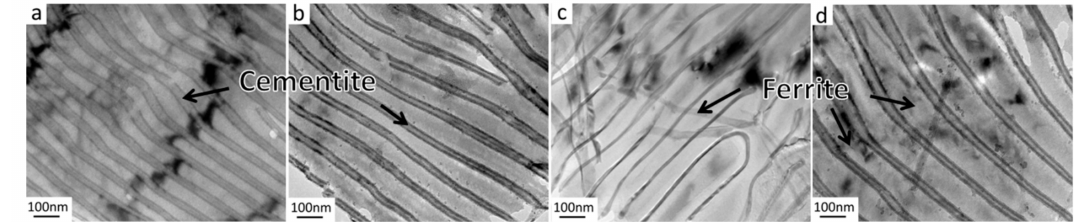
Figure 13. Pearlite interlamellar spacing at di ff erent cooling rates. ( a ) 4 ◦ C / s. ( b ) 3 ◦ C / s. ( c ) 2 ◦ C / s. ( d ) 1 ◦ C / s.